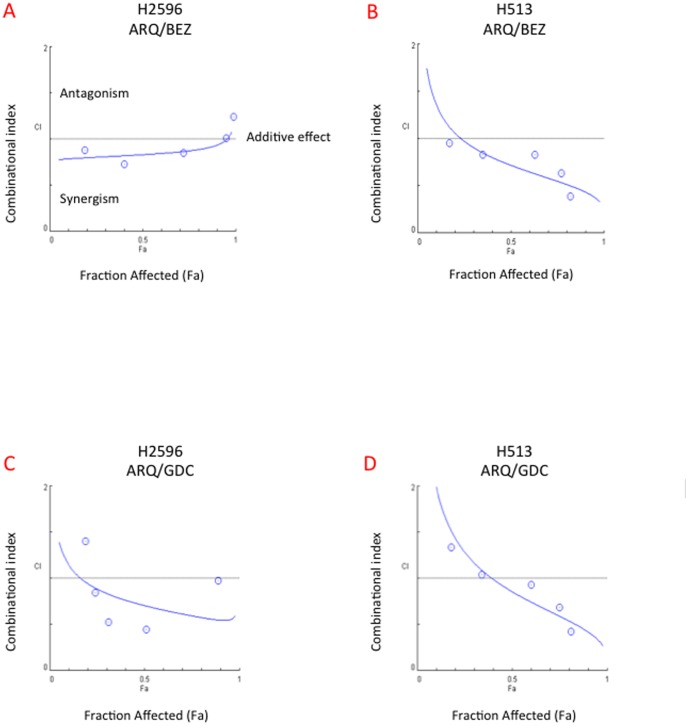
Synergistic anti-tumor activity of combination of ARQ 197 with NVP-BEZ235 and GDC-0980 in mesothelioma cell lines.Cells were treated with ARQ 197, NVP-BEZ235 and GDC-0980 alone or in combination at serial concentrations for 72 h. Cell viability was measured by Alamar Blue assay. Combination index (CI) plot analysis of ARQ 197/GDC-0980 and ARQ 197/NVP-BEZ235 combinations show that they interact synergistically in H2596 and H513 cells. CI = 1 shows additive effect, CI<1 is synergism and CI>1 is antagonism. Each experiment was carried out independently and repeated at least three times. (A)
CI plot of ARQ 197/BEZ235 in H2596 cells. (B)
CI plot of ARQ 197/BEZ235 in H513 cells. (C)
CI plot of ARQ 197/GDC0980 in H2596 cells. (D)
CI plot of ARQ 197/GDC0980 in H513 cells.